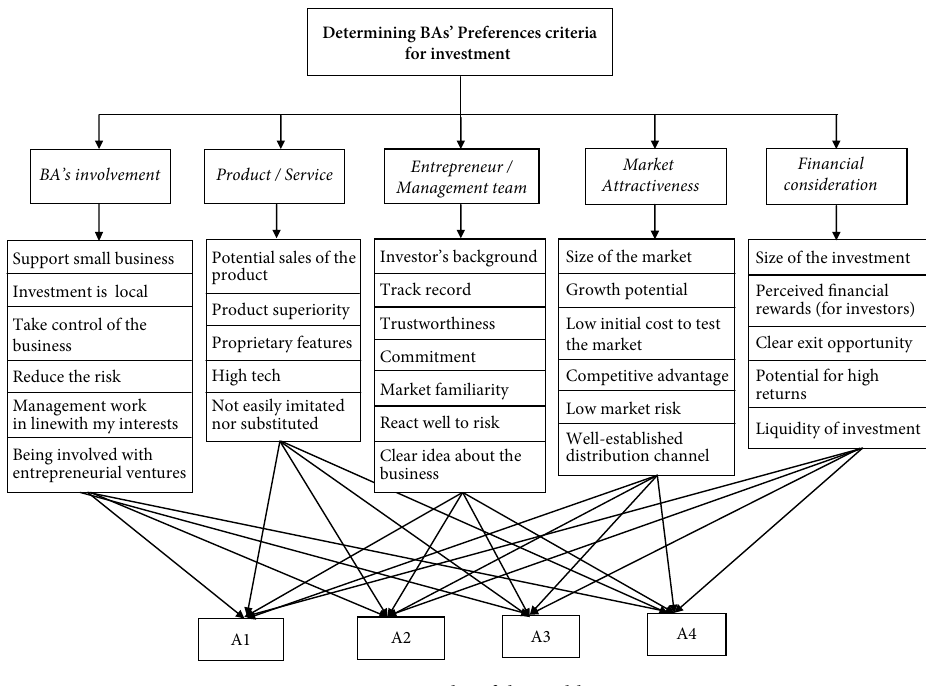
Fig. 2. Hierarchy of the